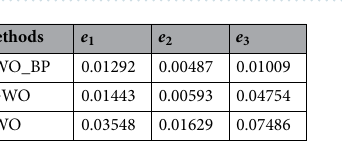
Figure 4. Modeling result graph of y 3 .